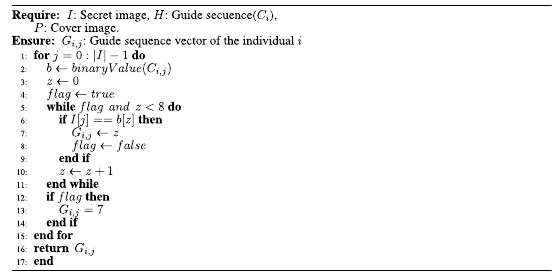
Algorithm 2. Calculation of the guide sequence G